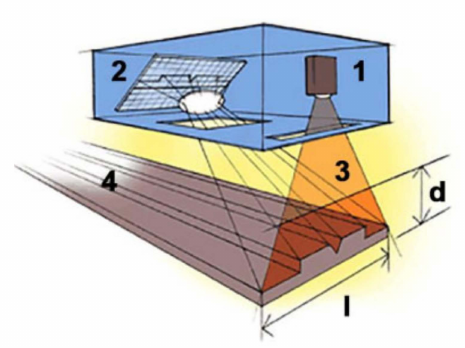
Figure 5. Principle of LPM measurement. (1) CMOS camera; (2) Laser light source; (3) Laser light on the surface; (4) Measured surface; (d) Working distance; (l) Measuring range.